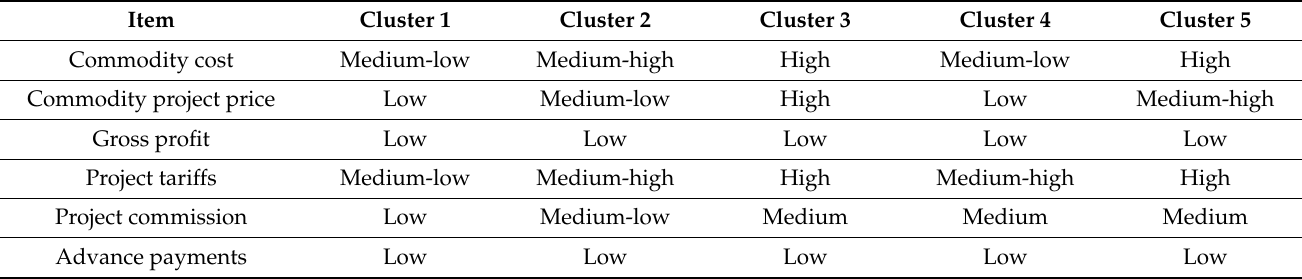
Table 4. Summary of clustering